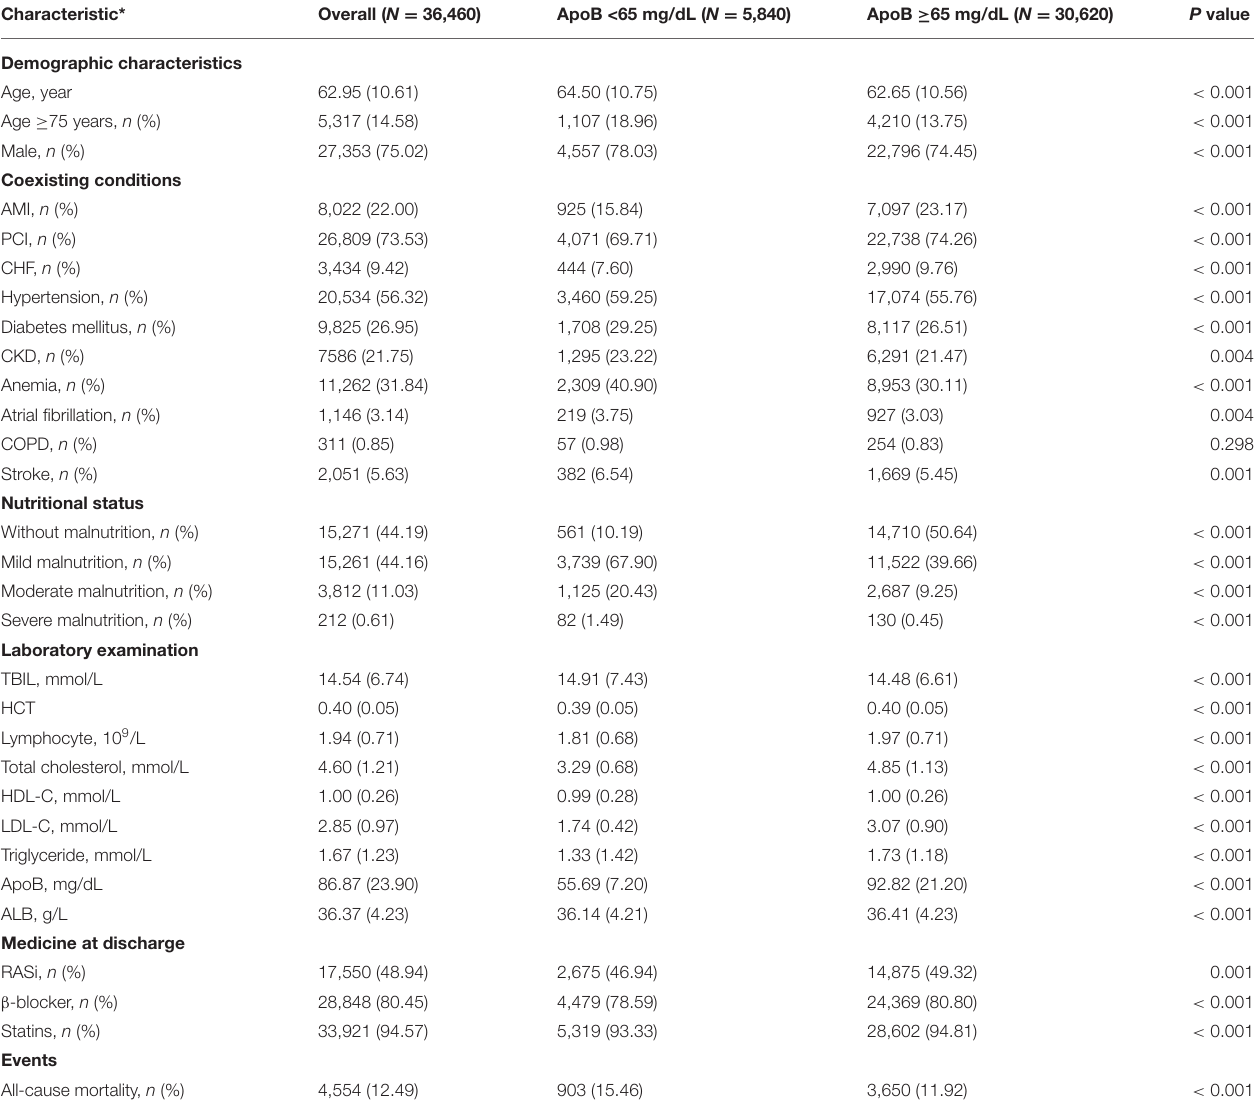
TABLE 1 | Baseline